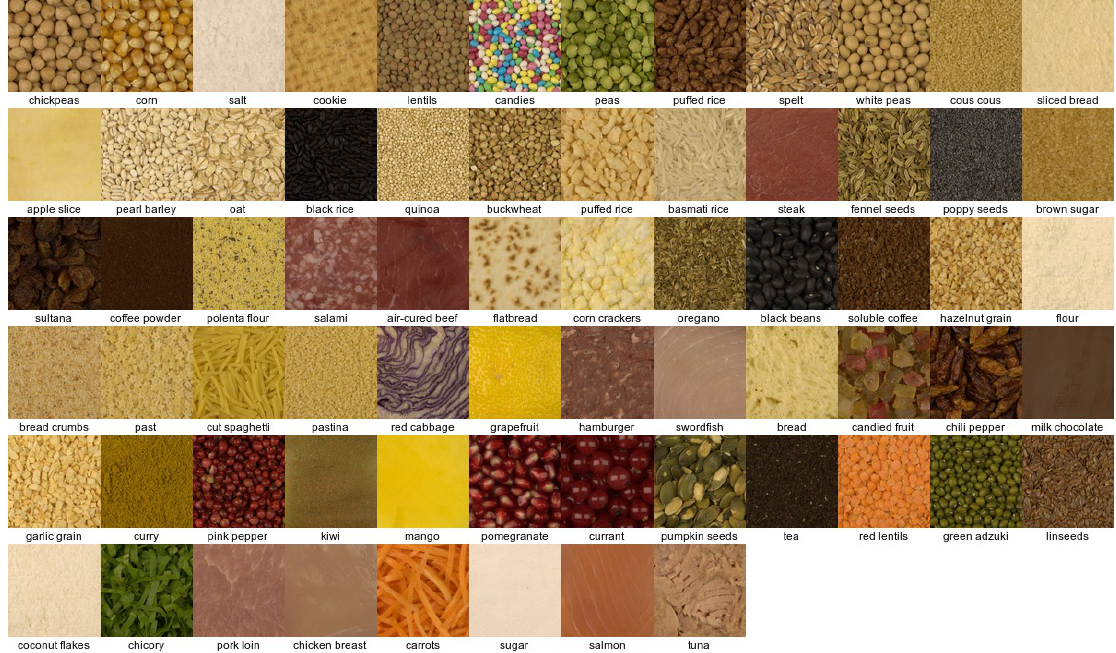
Figure 2. A sample for each of the 68 classes of textures composing the RawFooT